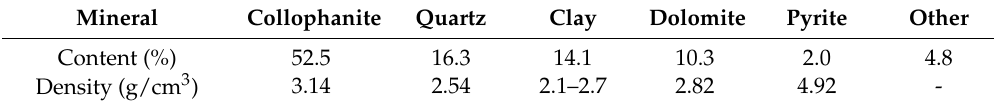
Table 2. Mineral composition of raw ore.